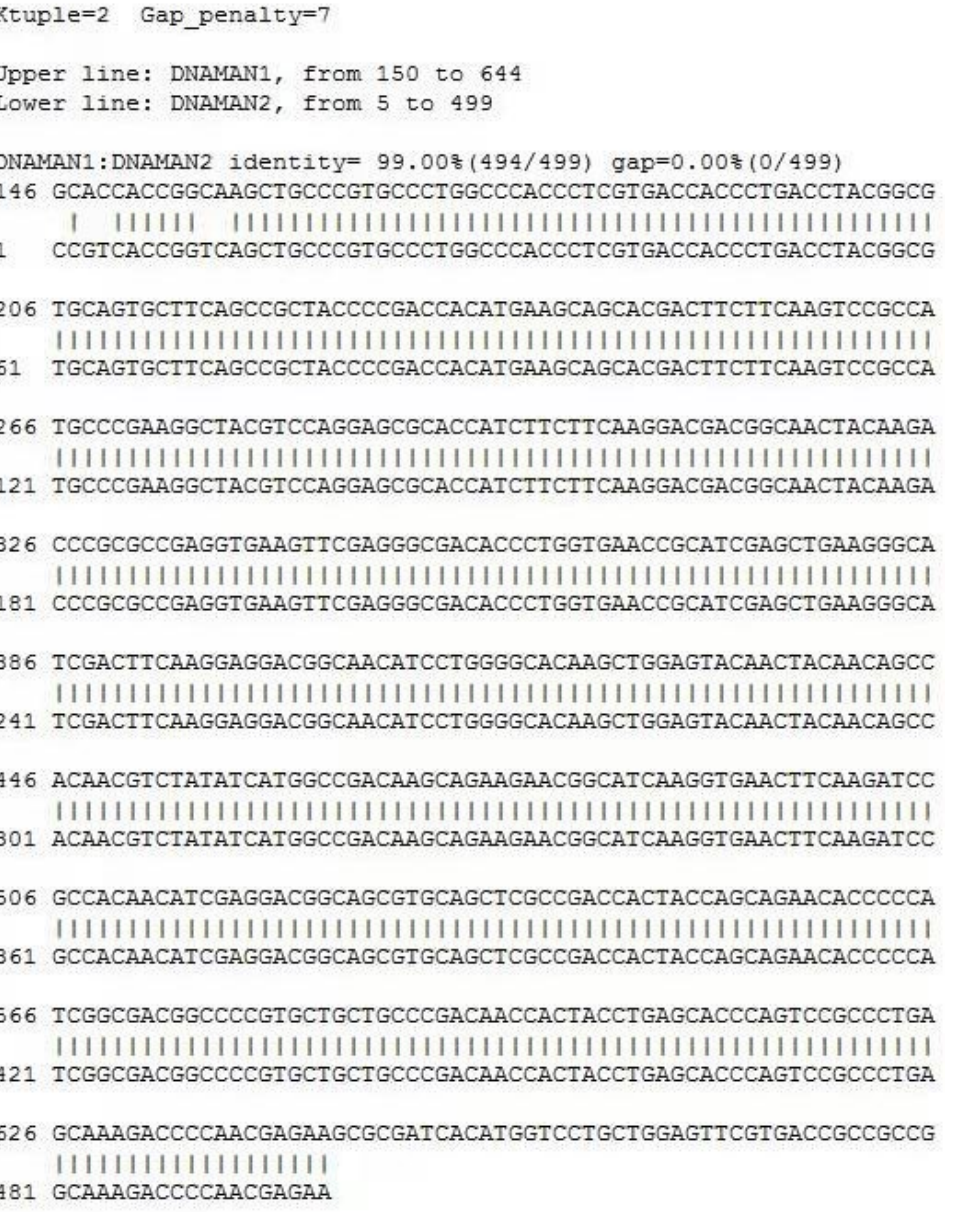
Figure 5. The sequence alignment of the EGFP gene was performed using first-generation sequencing techniques at the 8th week after EGFP lentivirus injection, and the alignment rate was 99%, which can prove that EGFP genes in SSCs are integrated into the sperm genome.